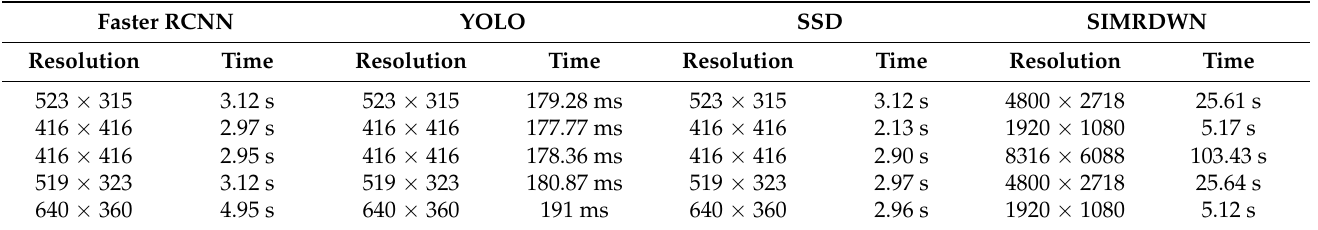
Table 7. Detection time of models on different resolution